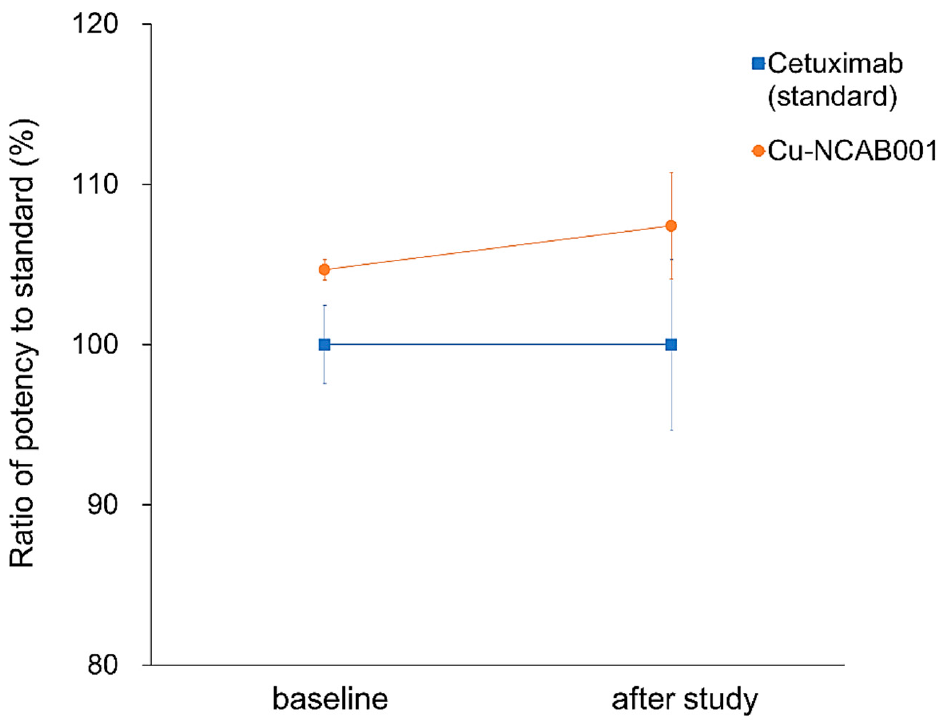
Figure 3. Relative binding potency of Cu-NCAB001 to recombinant human EGFR before and after the toxicity study was determined using the enzyme-linked immunosorbent assay (ELISA). Cetuximab was used as the reference standard. No statistically significant changes were observed. Table 3. Specifications of the Cu-NCAB001